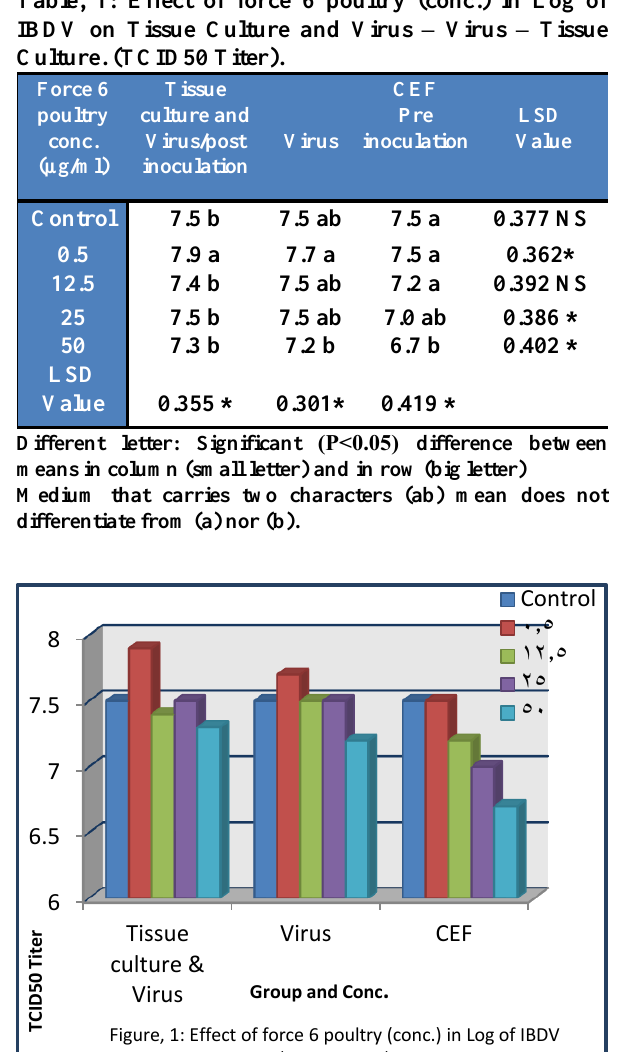
Figure, 1: Effect of force 6 poultry (conc.) in Log of IBDV (TCID50 Titer)